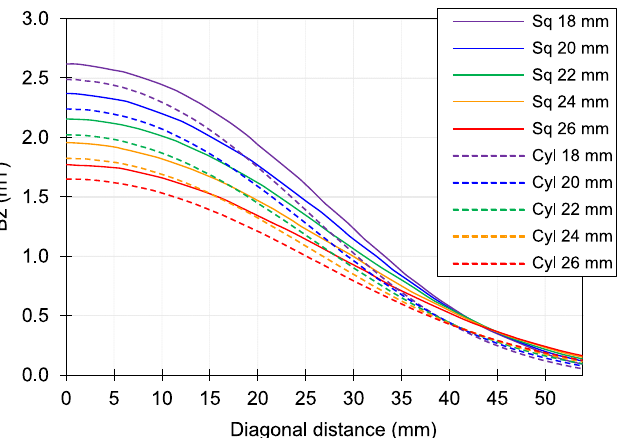
Figure 2. Magnetic flux density z-component B z comparison between square and cylindrical coils along the diagonal distance from center to corner at different levels.